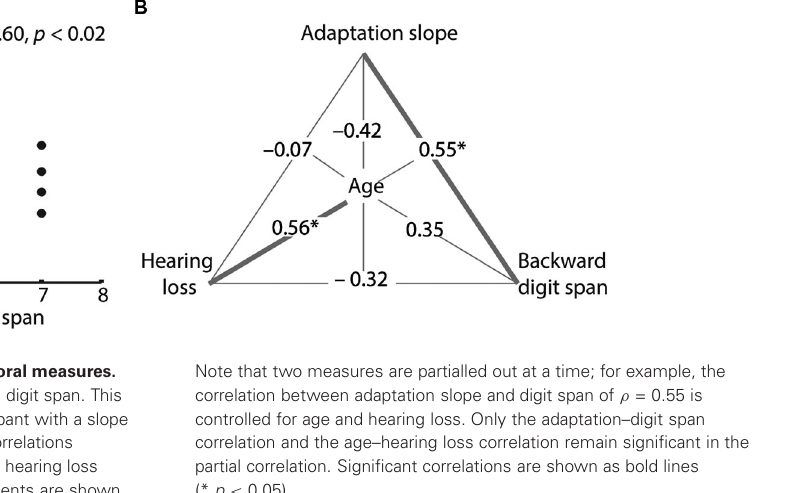
Note that two measures are partialled out at a time; for example, the correlation between adaptation slope and digit span of ρ = 0.55 is controlled for age and hearing loss. Only the adaptation–digit span correlation and the age–hearing loss correlation remain significant in the partial correlation. Significant correlations are shown as bold lines (* p <